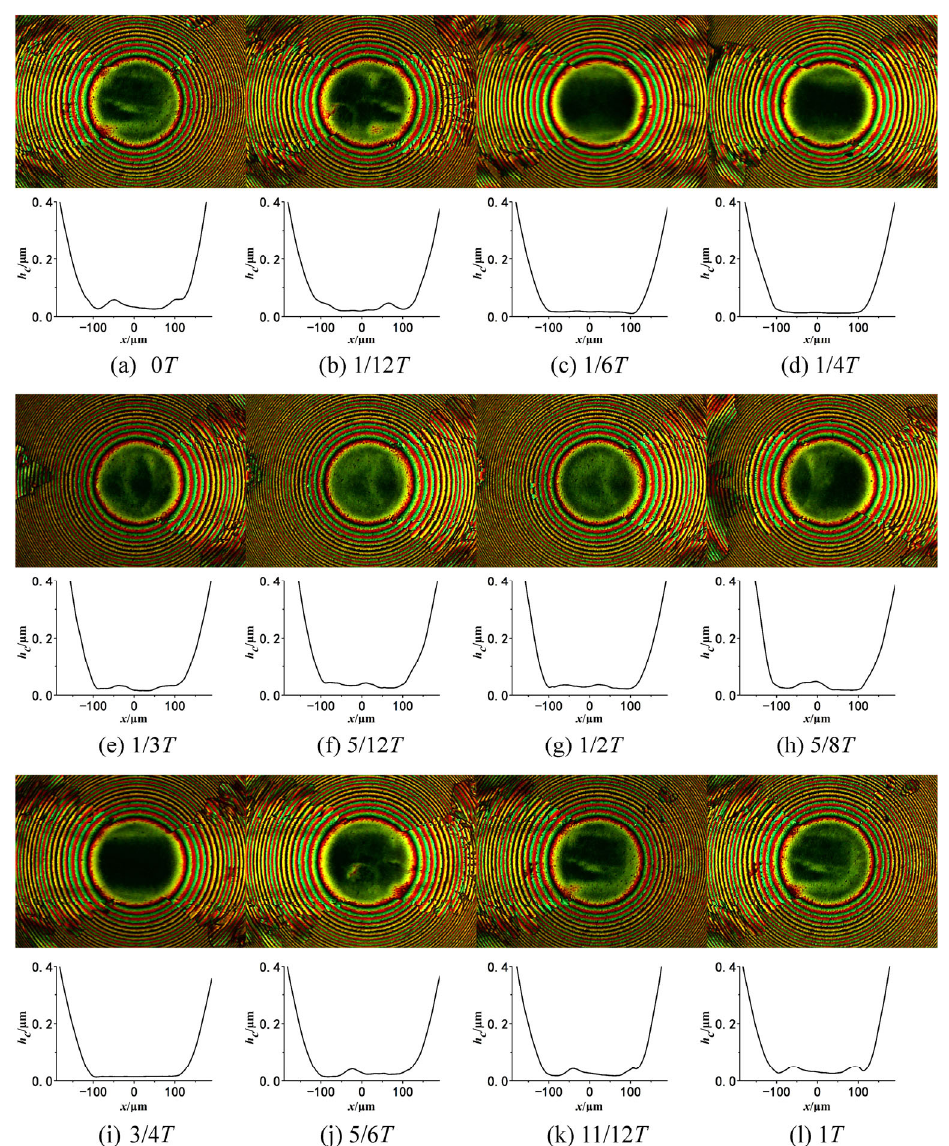
Fig. 7 Interferograms and midsection film thickness during 1,000th cycle under pure rolling reciprocating motion ( v max = 0.01 m/s, w = 15 N, T = 0.5 s, L = 1.25